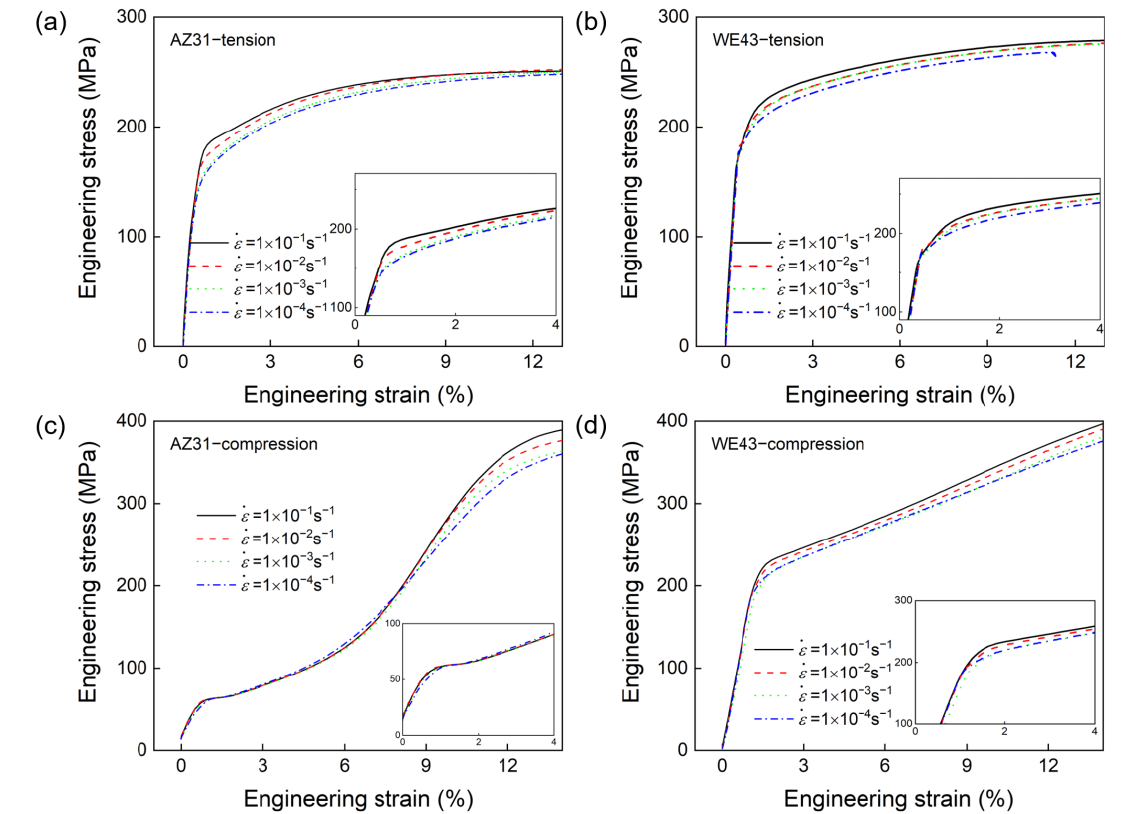
Figure 3. Engineering stress−strain curves of the AZ31 and WE43 alloy samples in RD: ( a , b ) tensile; ( c , d ) compression under different strain rates. Both ( a ) AZ31 and ( b ) WE43 alloy samples showed obviously positive strain rate sensitivity in tension. This mechanical behavior was ascribed to the strain rate dependency of non-basal slip systems. ( c ) The mechanical behavior of the AZ31 alloy showed strain rate independence in the early deformation stage under compression. Then, it exhibited a positive SRS as the engineering strain increased to 8%. This can be mainly attributed to the influence of the interplay between twinning and slip. ( d ) The evolution of flow stress with the strain was similar to that observed in the tensile test of ( b ) the WE43